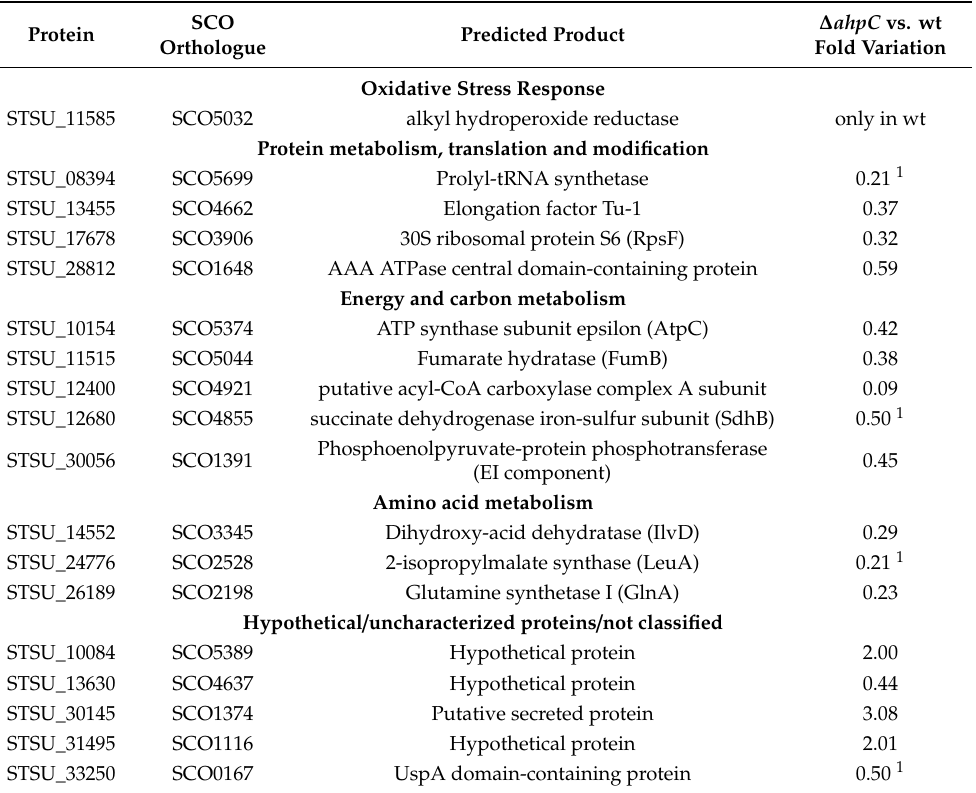
Table 1. Identified proteins with significant di ff erences ( p < 0.05) in the 2D-PAGE comparison between wild type and ∆ ahpC strains. Fold variation is expressed as the ratio between the mean abundance of protein in the (cid:44) ahpC strain and the mean abundance of protein in the wild type (wt). Each mean abundance is calculated from at least three independent